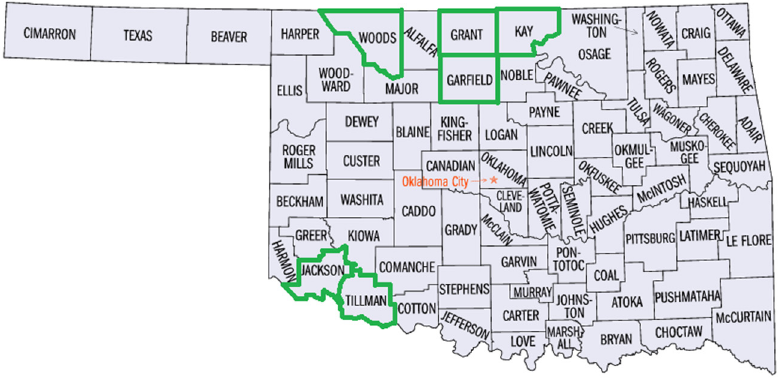
Figure 8. Counties of Oklahoma, with green outlines indicating a county is considered as a potential supplier of algal biomass based on having the top 25% of well depth. Base map from U.S. Census Bureau [26]. Table 2. Marginal farmland and average agricultural land cost for counties considered as potential suppliers of algal biomass. [27,29].